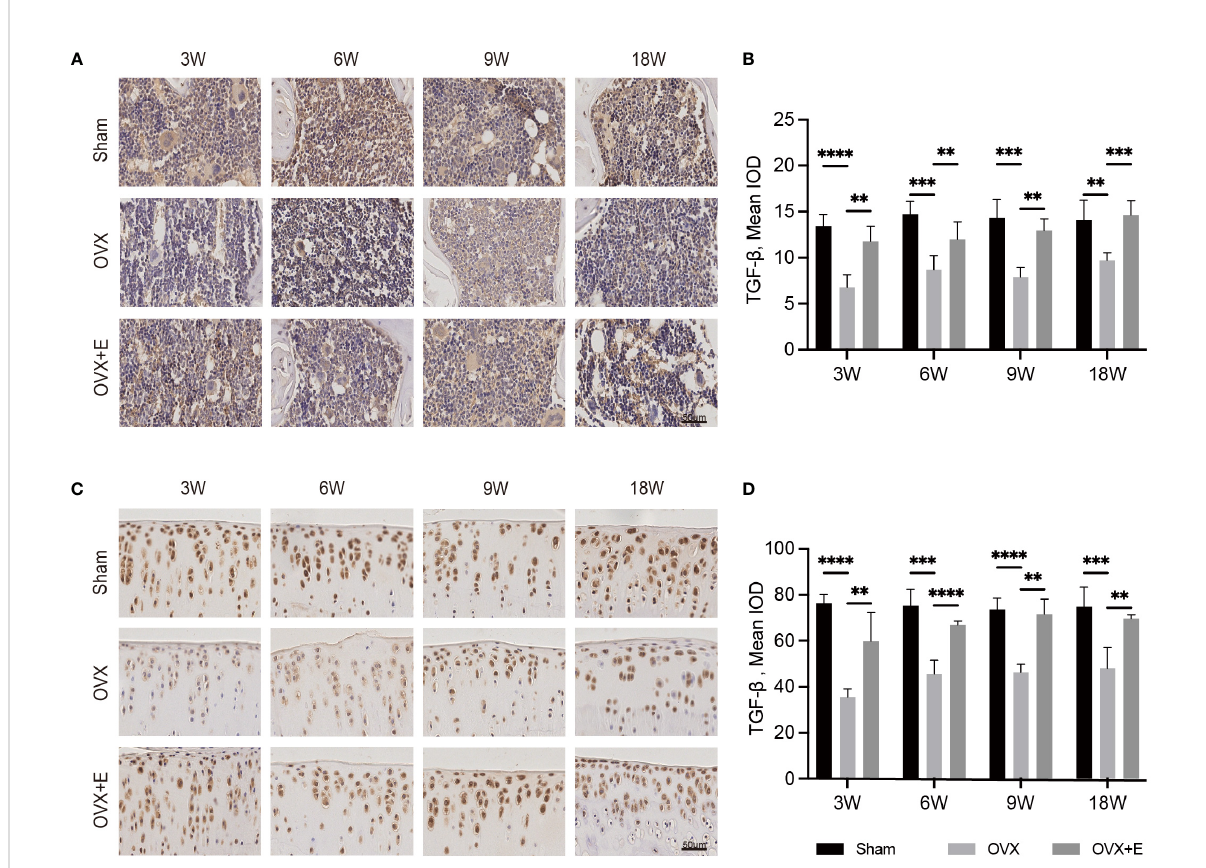
FIGURE 5 The change in the osteochondral unit involves TGF- b signaling. Immunohistochemical staining of TGF- b in subchondral bone (A) and articular cartilage (C) . The mean IOD of TGF- b in subchondral bone (B) and articular cartilage (D) (n = 7). The mean IOD indicates the mean